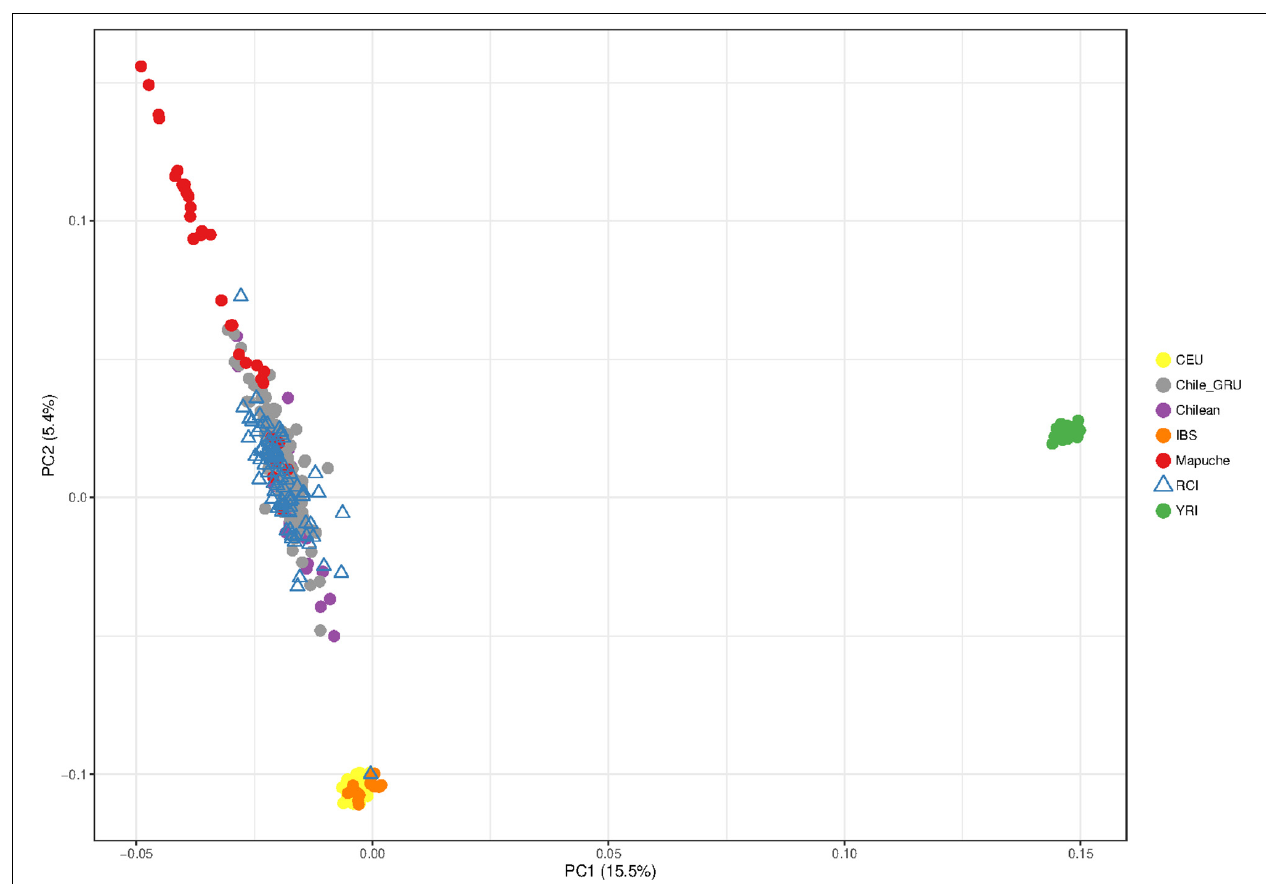
FIGURE 5 | Principal component analysis showing the population structure of Robinson Crusoe Island (RCI) ( N = 86) (blue triangle) compared to Chilean controls (from Santiago) (purple). Data from the non-indigenous “Evaluation of Ancestry Admixture Among Chileans” (Chile_GRU) ( N = 144) study (Lorenzo Bermejo et al., 2017) are shown in gray, with individuals from this study who self-identify as of Mapuche indigenous ancestry (Mapuche) ( N = 32) in red. European (CEU) ( N = 40) (yellow), Iberian (IBS) ( N = 14) (orange), and Yoruba African (YRI) ( N = 40) (green) from 1000 Genomes populations are also